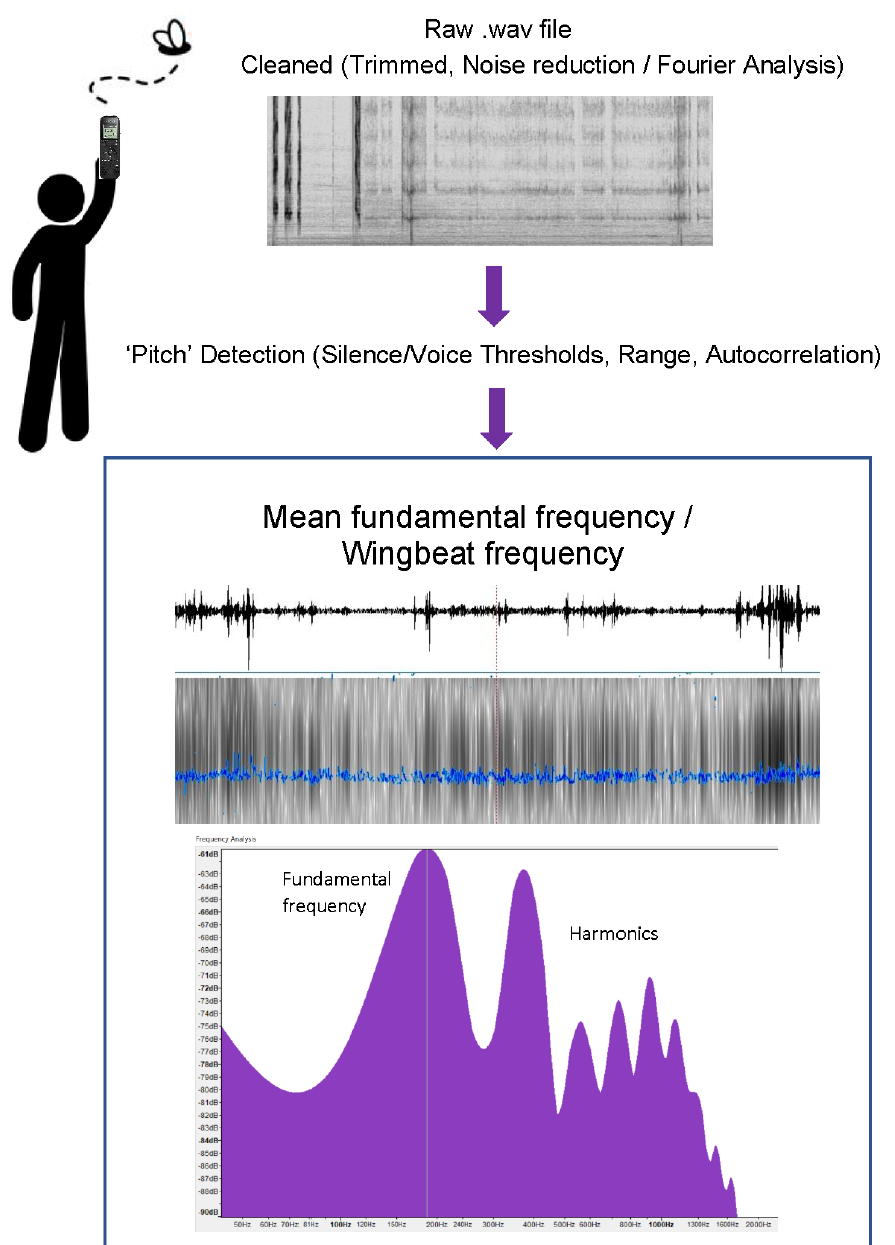
Figure 1. Overall methodology showing transition from raw recording to determination of mean wingbeat frequency for an individual specimen. Example shown is for male C. dubia .